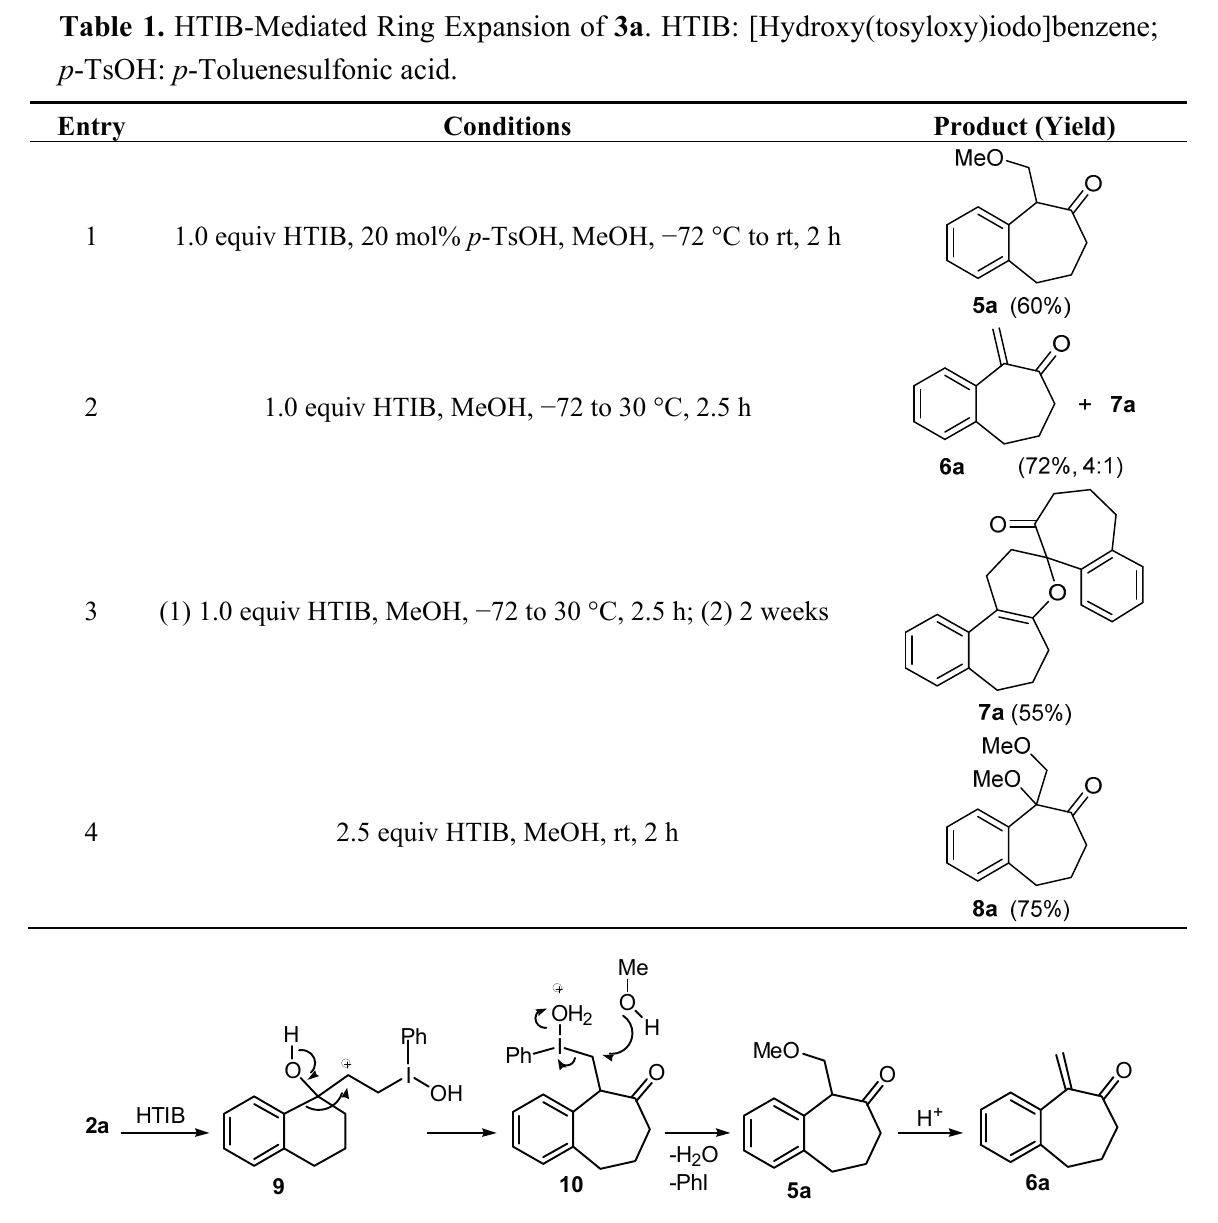
Scheme 2. Mechanism of the Ring Expansion of 2a . HTIB: